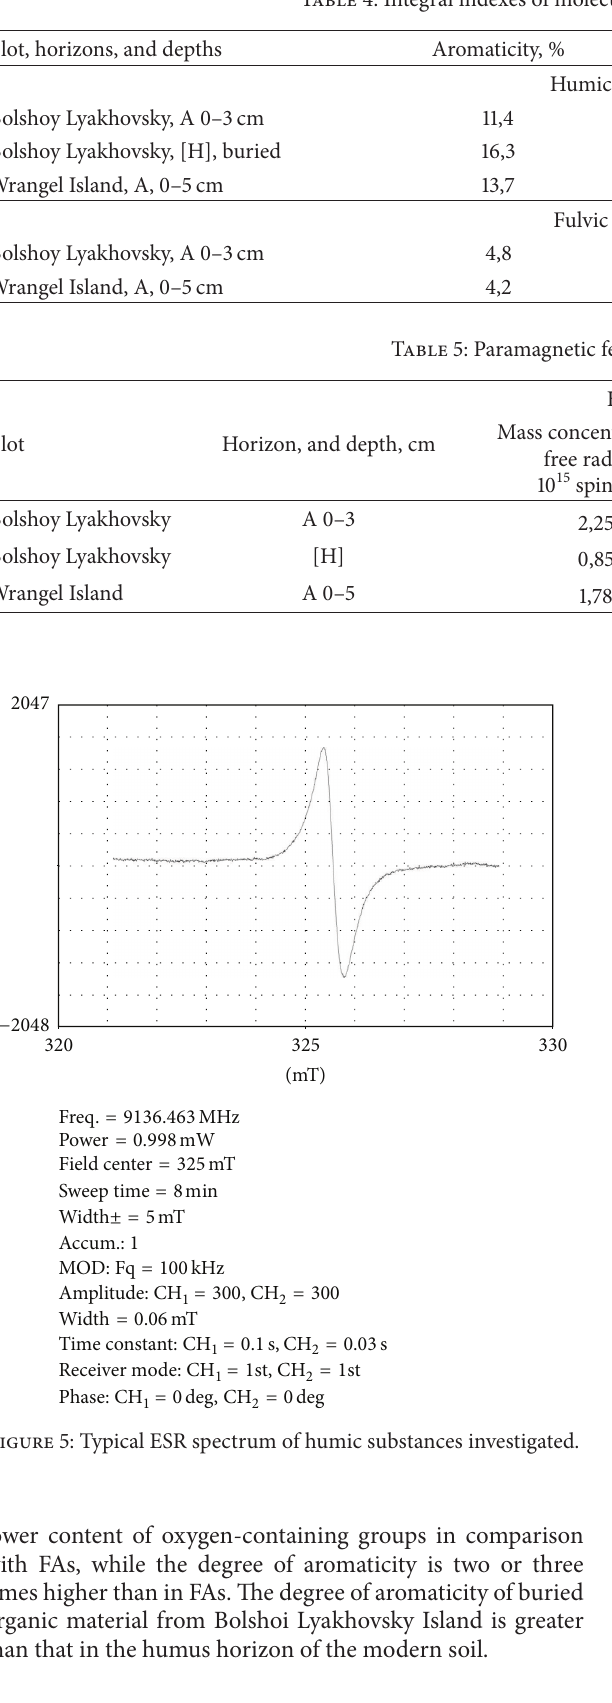
Table 4: Integral indexes of molecular composition of HAs and FAs.